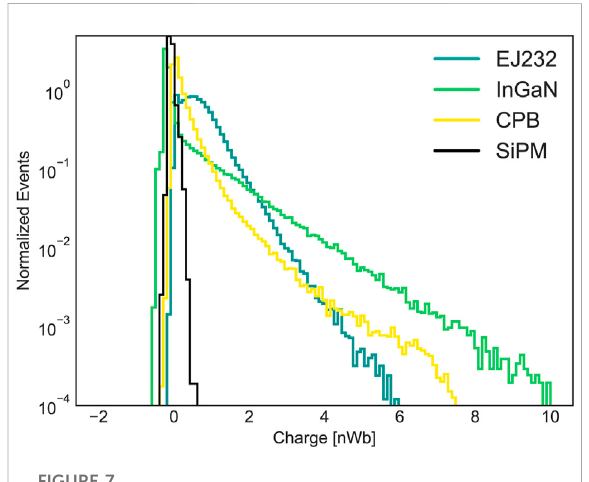
FIGURE 8 Finger plot of the energy (EN) channel obtained from a